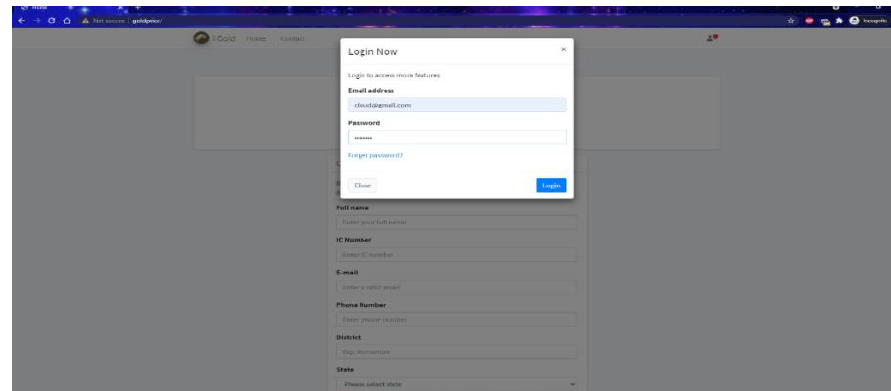
Figure 2. Login page.